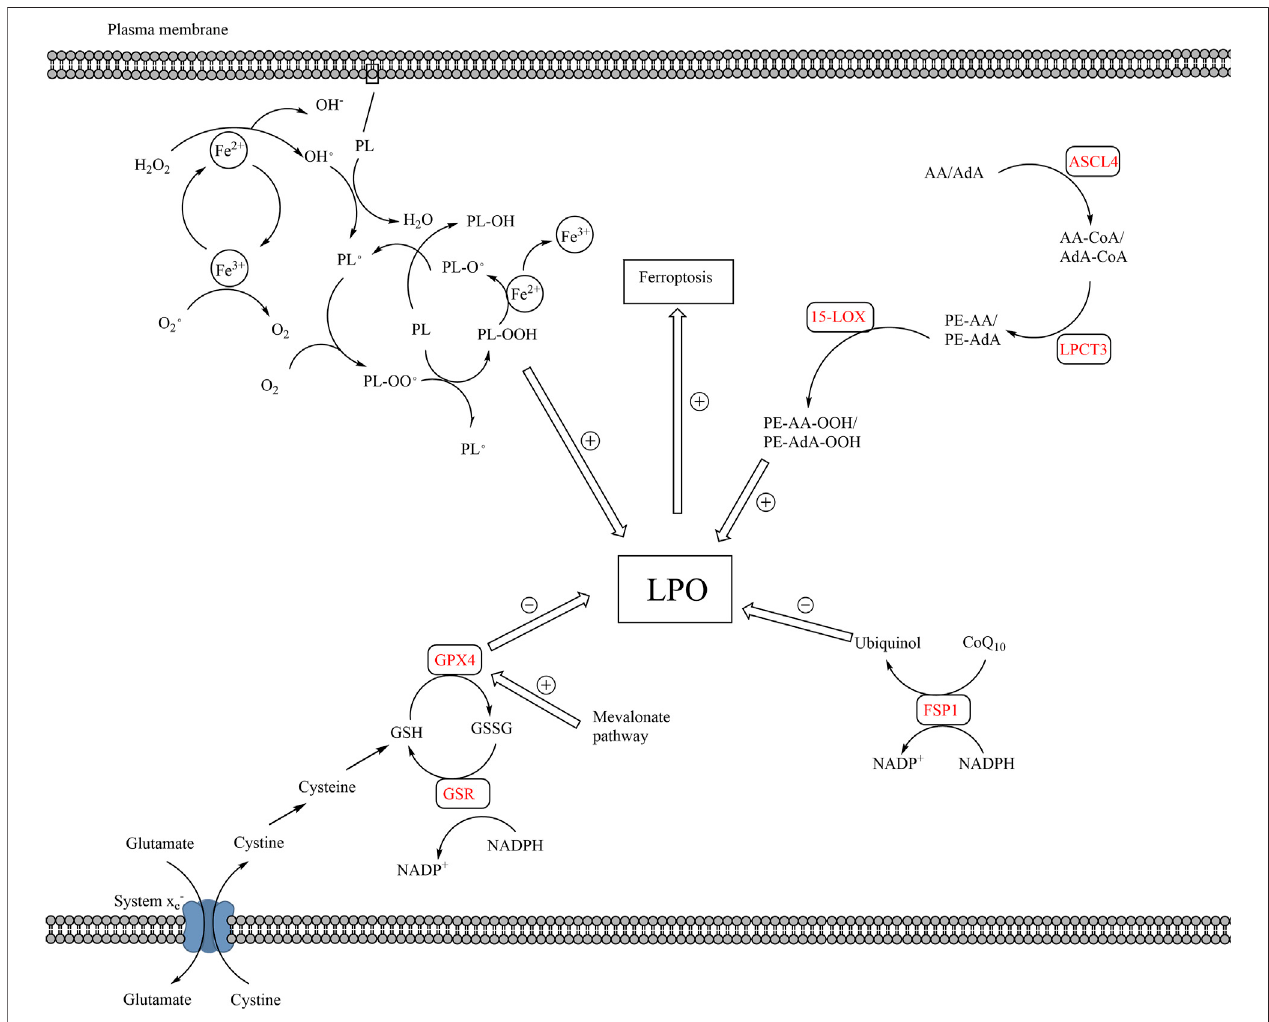
FIGURE2| Thepathwaysoflipidperoxidation andferroptosis.TheproductionofLPOmainlyresultsfromauto-oxidationoflipidsandenzymaticlipidperoxidation. (cid:129) Auto-oxidation of lipid is a radical reaction, which means the upstream reaction can induce the downstream reaction. PL is converted to PL by ROS, which is the (cid:129) (cid:129) (cid:129) productionofFe 2+ andH 2 O 2 .PL reacts withO 2 toform PL-OO ,which furtherreacts withanew PLtoformPL-OOHand anewPL ,proceeding downstreamradical reaction. Enzymatic lipid peroxidation mainly takes place in AA or AdA. AA and AdA can be converted into PE-AA-OOH and PE-AdA-OOH by the catalysis of ACSL4, LPCAT3, and 15-LOX. The elimination of LPO mainly relies on GPX4 and FSP1. Cystine is transported into cells via system x c − , which is the raw material for the production of GSH. GPX4 converts GSH to GSSH and reduces LPO in the meantime. Besides, FPS1 converts CoQ 10 to ubiquinol, which reduces LPO. The accumulation of LPO, caused by excessive production or blockage of elimination of LPO, leads to ferroptosis. (15-LOX, 15-lipoxygenases; AA, arachidonoyl; ACSL4, acyl-CoA synthetase long-chain family member 4; AdA, adrenoyl; CoQ 10 , coenzyme Q 10 ; FSP1, ferroptosis suppressor protein 1; LPO, lethal lipid peroxides;